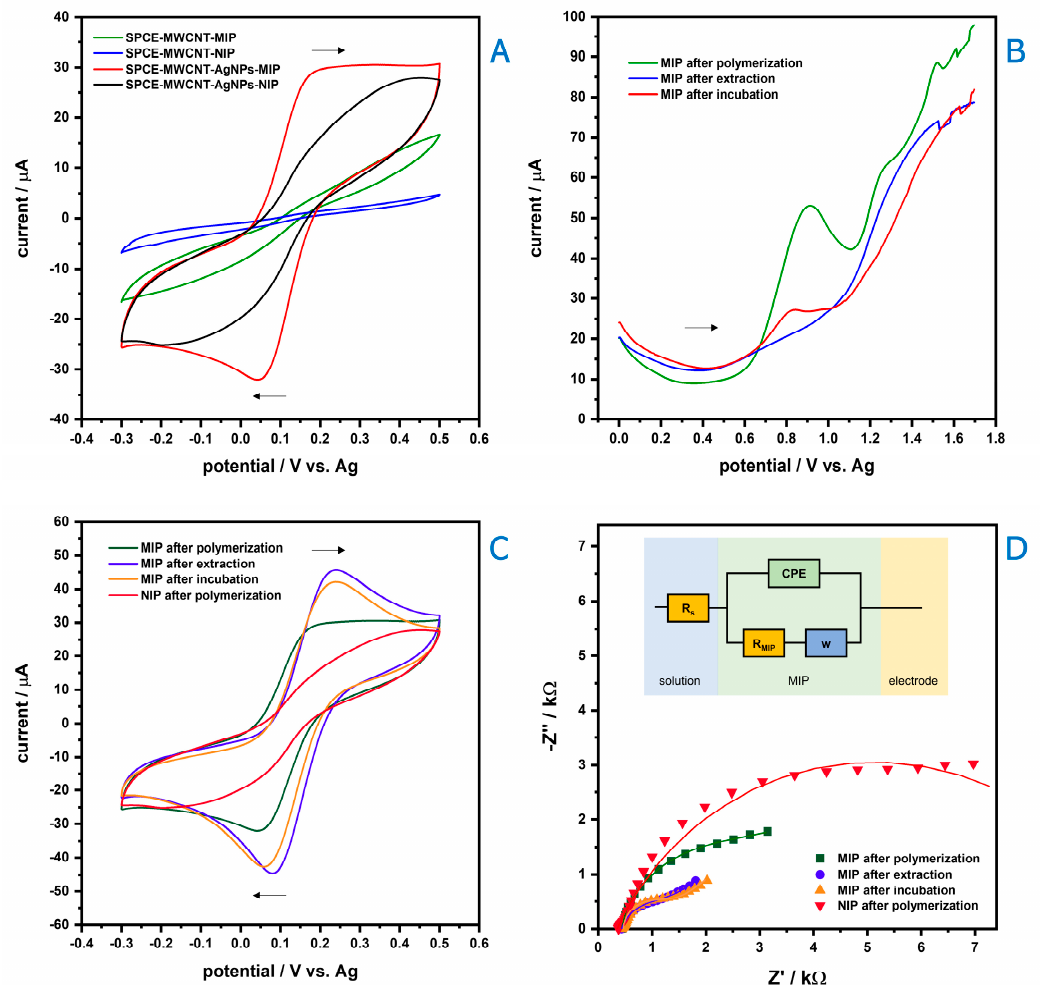
Figure 2. CV characterization of MIP and NIP sensors developed on SPCE-MWCNT and SPCE-MWCNT/AgNP electrodes ( A ); SWVs of a 0.1 mol L -1 MDPV solution after polymerization, extraction and incubation steps ( B ); Characterization of the step-by-step construction of the SPCE-MWCNT/AgNP-MIP sensor through CV ( C ) and EIS Nyquist diagrams with suitable fitting (the circuit used is shown within the figure) ( D ). Measurements ( A , C , D ) were performed using a 50 μ L PBS solution containing 2.5 mmol L –1 [Fe (CN) 6 )] 3-/4- and 0.1 mol L –1 KCl.